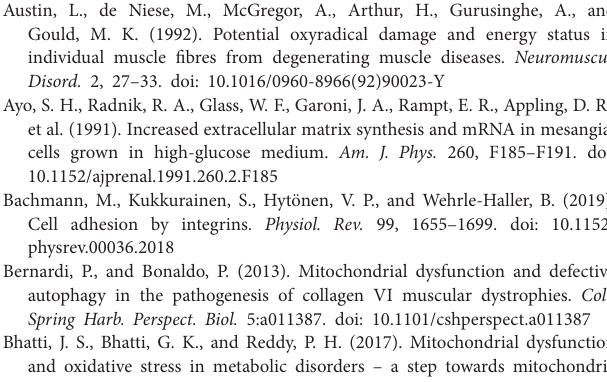
FIGURE 3 | phosphorylation of STAT3, which is implicated in the reduction of ROS and maintenance of mitochondrial membrane potential (1). Maintaining ECM integrity and cell adhesion contributes to sustain nutrient uptake and phosphatidyl-inositol-3-kinase (PI3K)/AKT signaling, together reinforcing metabolic regulation, and preventing accumulation of ROS (2). Biomechanical properties of the ECM are also critical to maintain cell structure (3). An appropriate ECM stiffness maintains mitochondrial dynamics, possibly preventing ROS production, and nuclear structure, supporting genomic integrity and avoiding DNA damage. Dashed lines represent pathways that may involve one or more intermediate